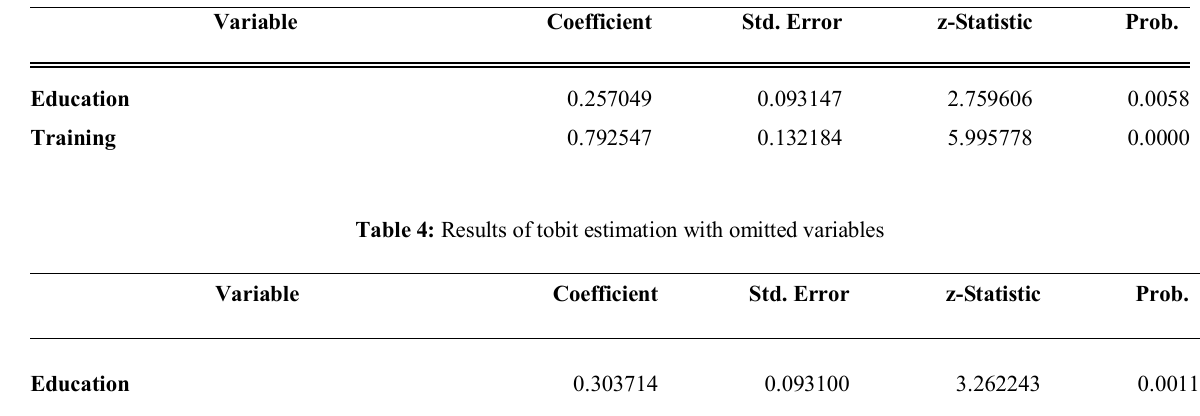
Table 3: Results of tobit estimation for initial model